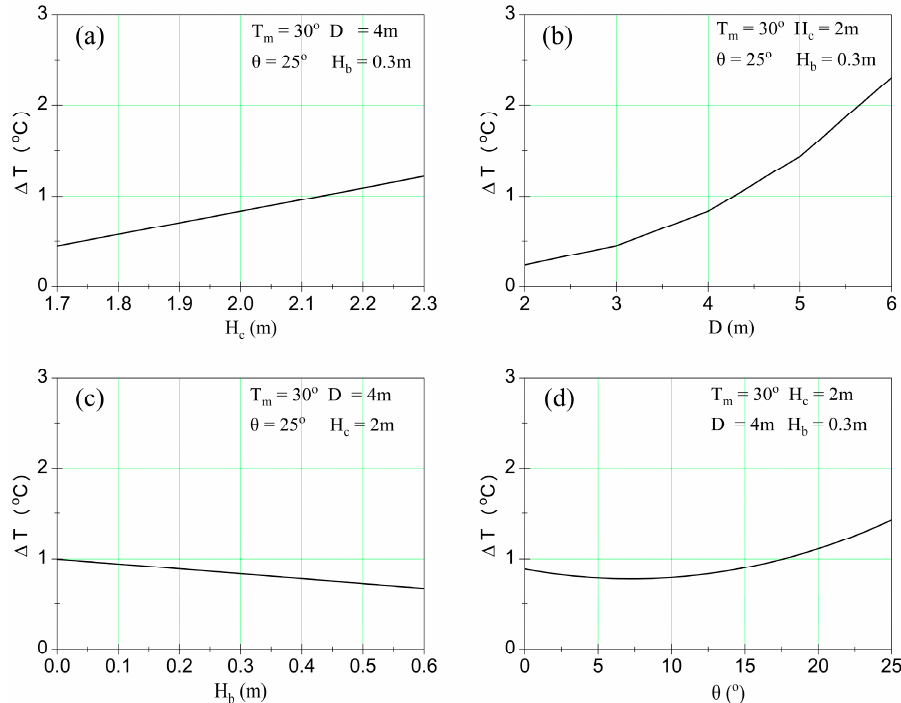
Figure 5. Perturbation of the relative significance of factors, including the camera height ( a ), hori- zontal distance ( b ), object height ( c ), and angle of view ( d ), on